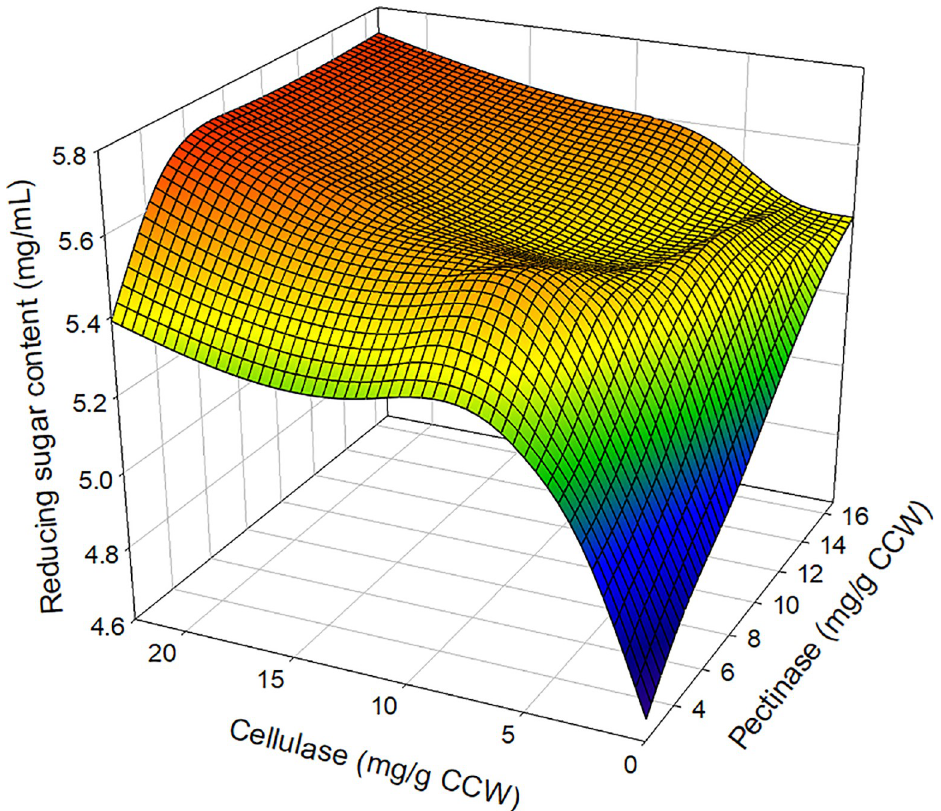
Fig 3. Three-dimensional (3D) profiles of reducing sugar production according to the enzyme loading content.